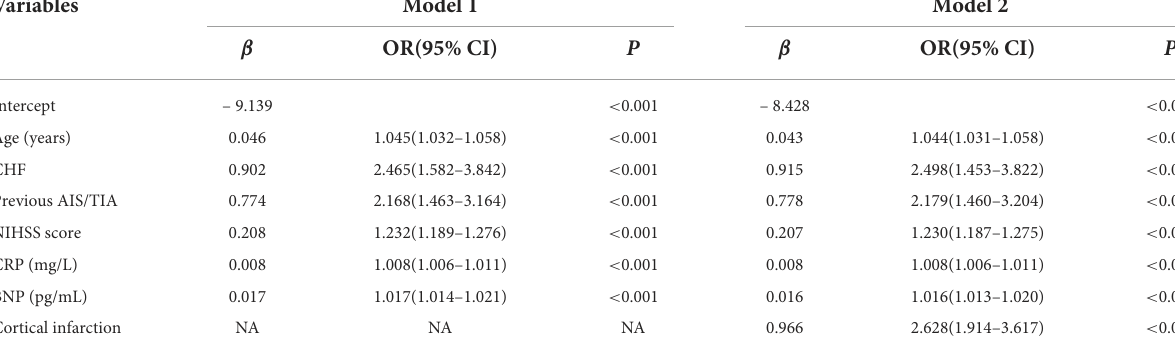
model1:basedonsimplifiedClinicalfeaturesandlaboratoryvariablesalone.